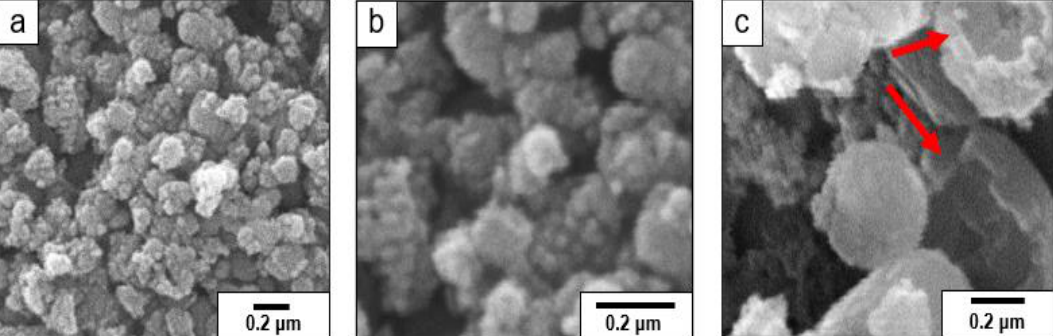
Figure 2. SEM images of α -Fe 2 O 3 particles autoclaved for 2 h at 120 ◦ C ( a ), 6 h at 160 ◦ C ( b ), and Fe 3 O 4 (NHS) autoclaved for 8 h at 180 ◦ C ( c ) Red arrows point to areas where the hollow cavity of the particles can be observed in Fe 3 O 4 (NHS).